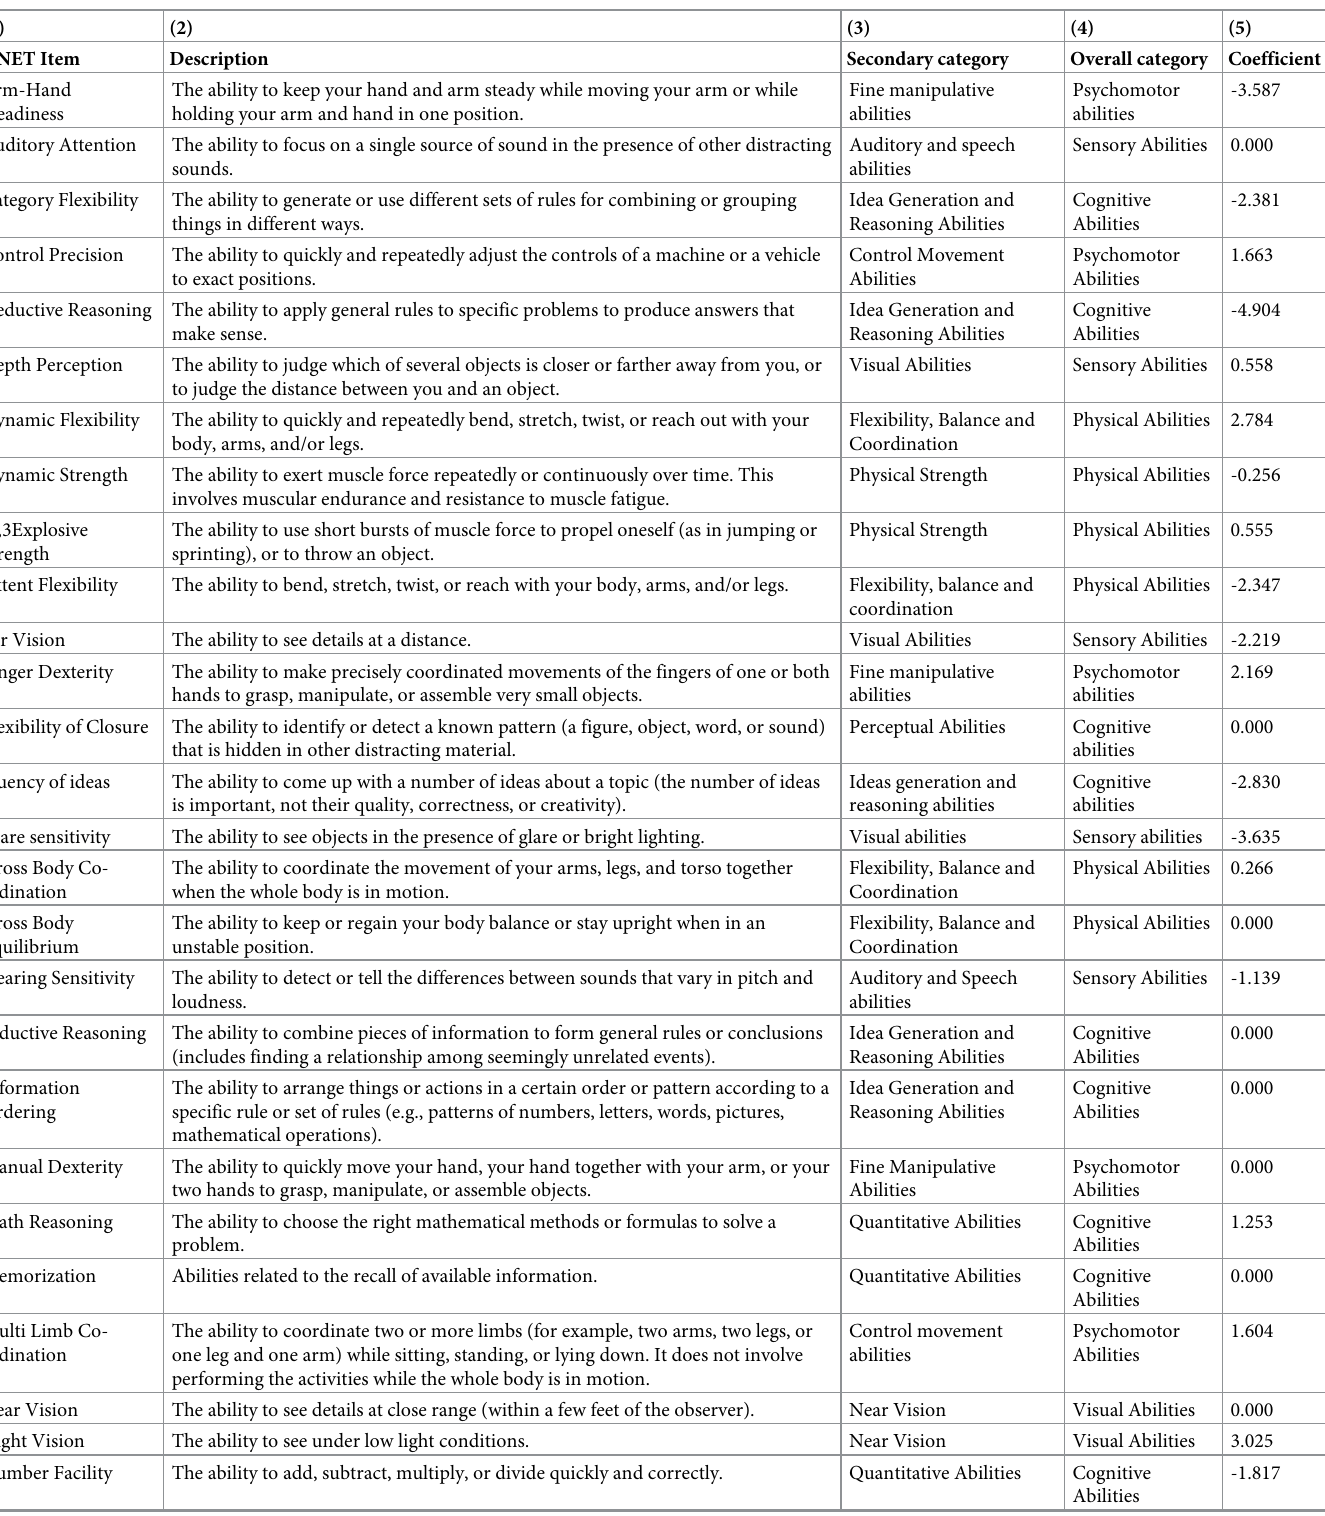
Table 2. Abilities